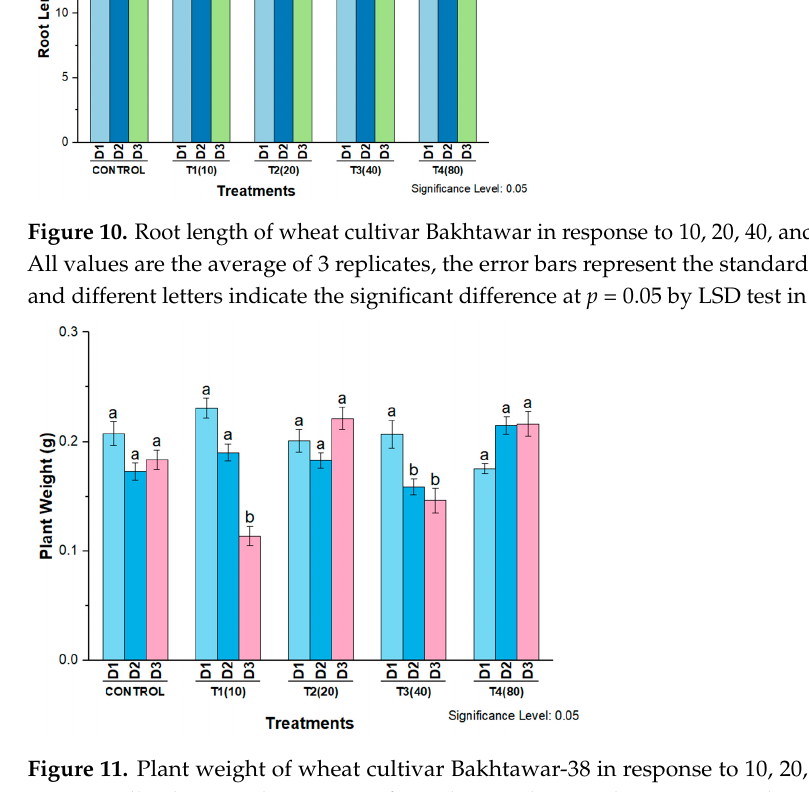
Figure 9. Shoot length of wheat cultivar Bakhtawar-38 in response to 10, 20, 40, and 80 mg/L of AgNPs. All values are the average of 3 replicates, error bars represent the standard errors of the means, and different letters indicate the significant difference at p = 0.05 by LSD test in each group. For root length, a favorable effect was observed on 40 mg/L and 80 mg/L AgNPs compared to control plants on all three days after treatment. However, at an exposure level of 20 mg/L, root length initially increased on the first and second days before de- creasing on the third day. In response to 10 mg/L AgNPs, root length was significantly increased on days one and three compared to control plants (Figure 10).